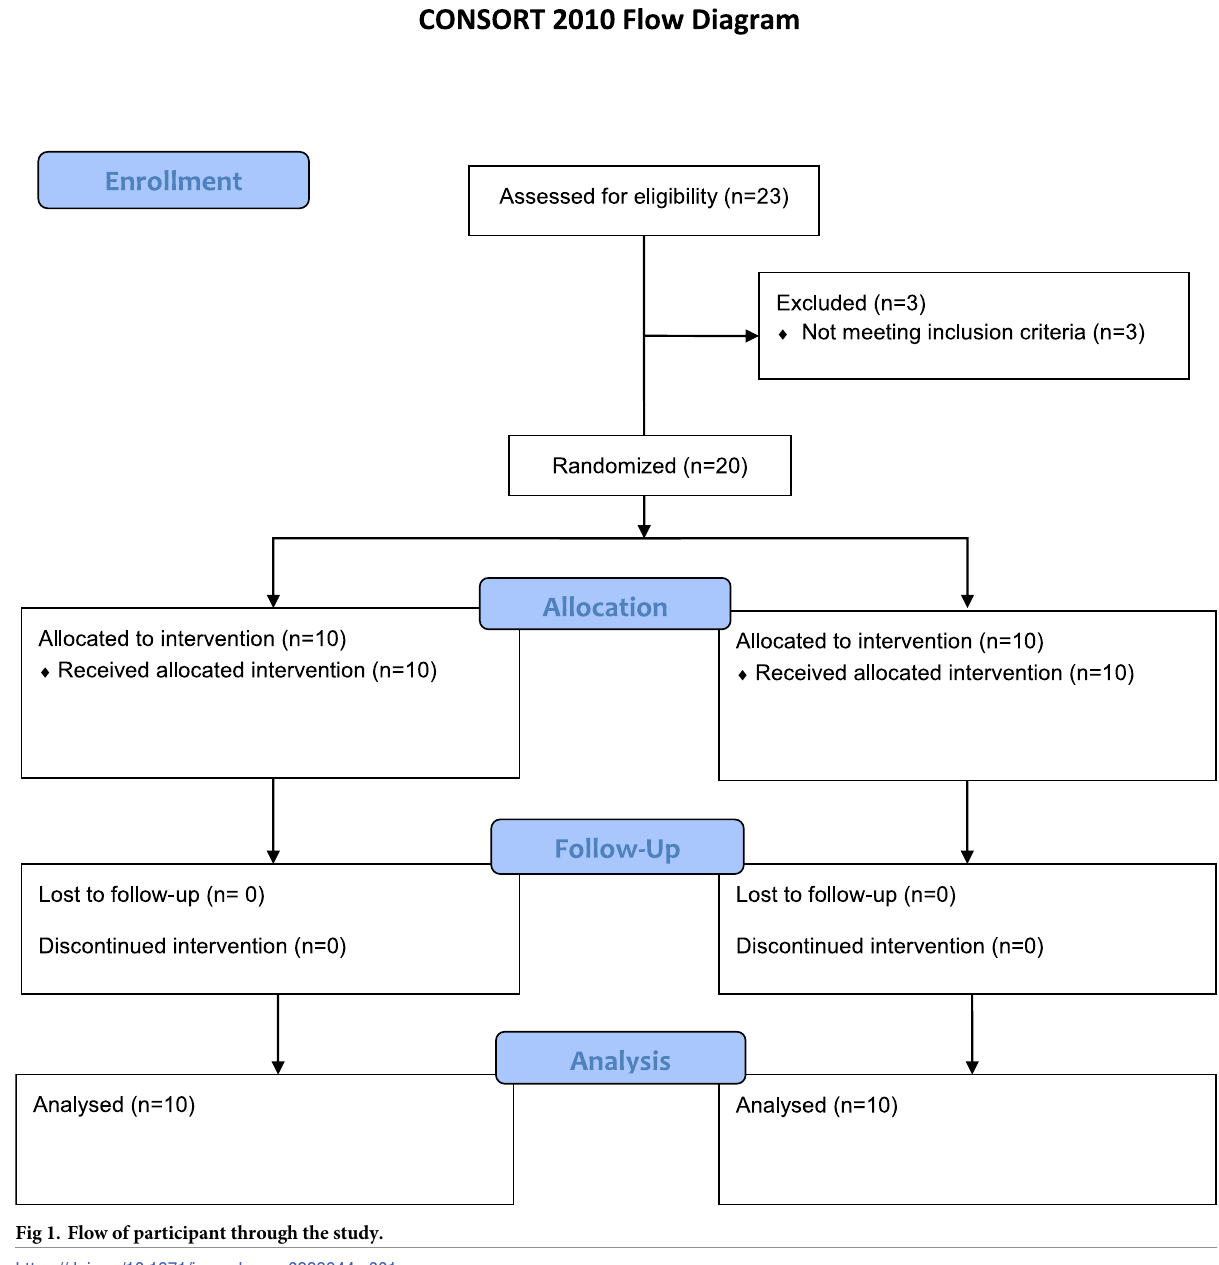
Fig 1. Flow of participant through the